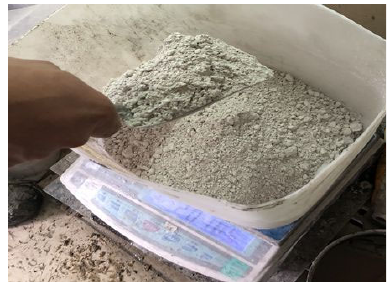
Figure 1. Granulated blast furnace